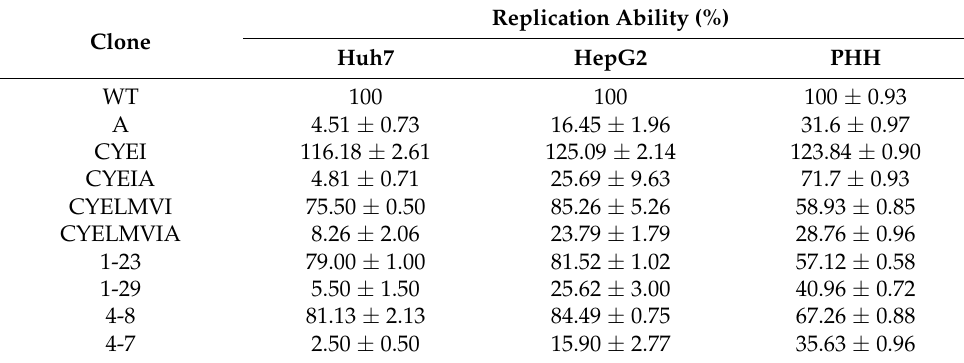
Table 4. Relative replication ability of mutant clones among Huh7, HepG2 cells, and PHHs compared to that of wild